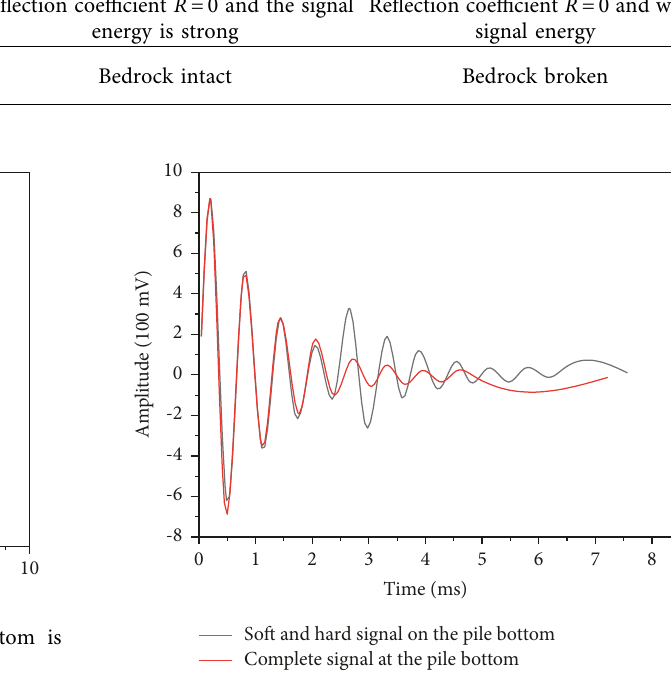
Figure 3: Ideal reflected signal with soft top and bottom hard bottom.